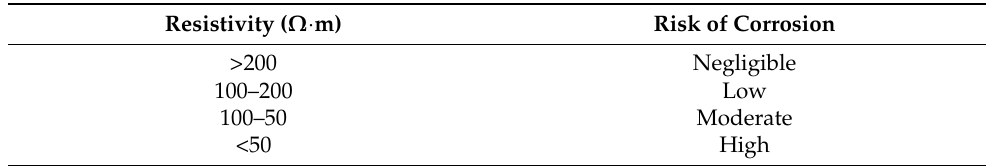
Table 3. Resistivity ranges related to the risk of corrosion [34].